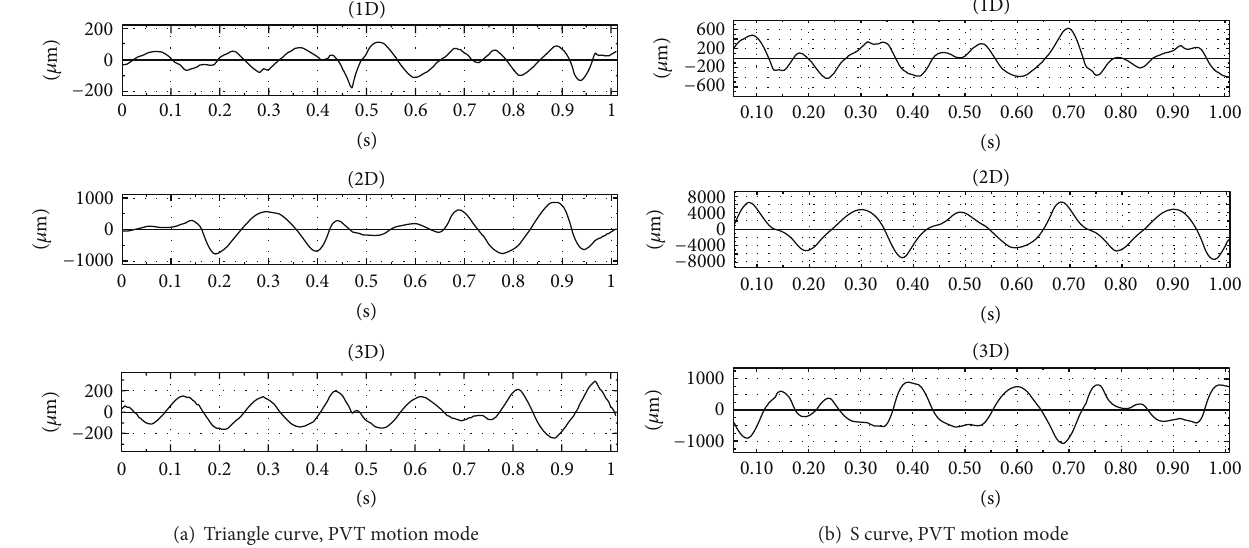
(b) S curve, PVT motion mode